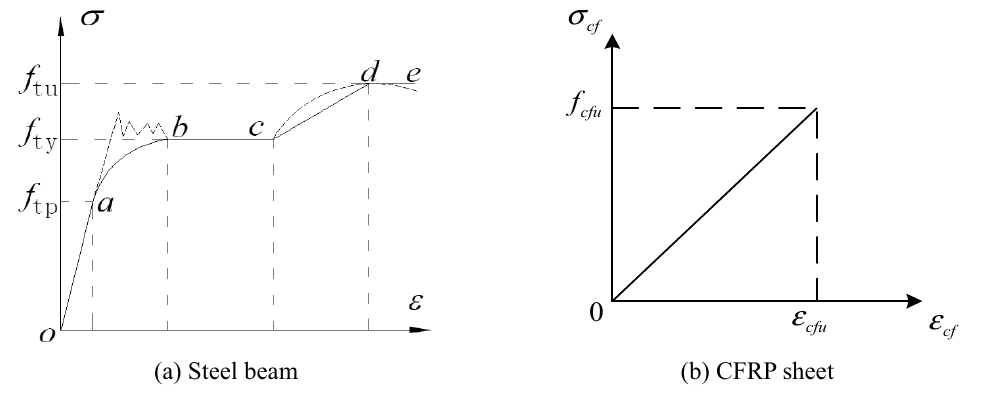
Figure 11. Stress–strain